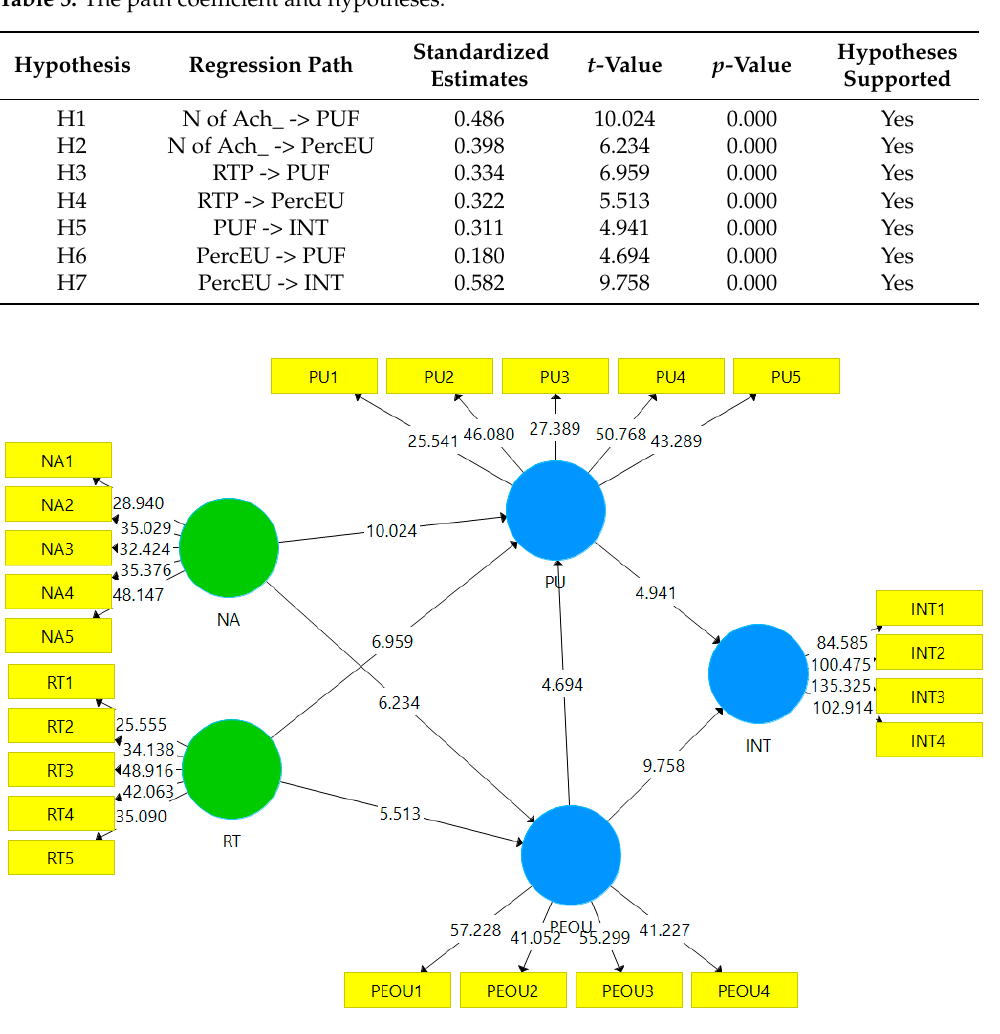
Figure 3. Structural model (T-value). Table 5. The path coefficient and hypotheses.